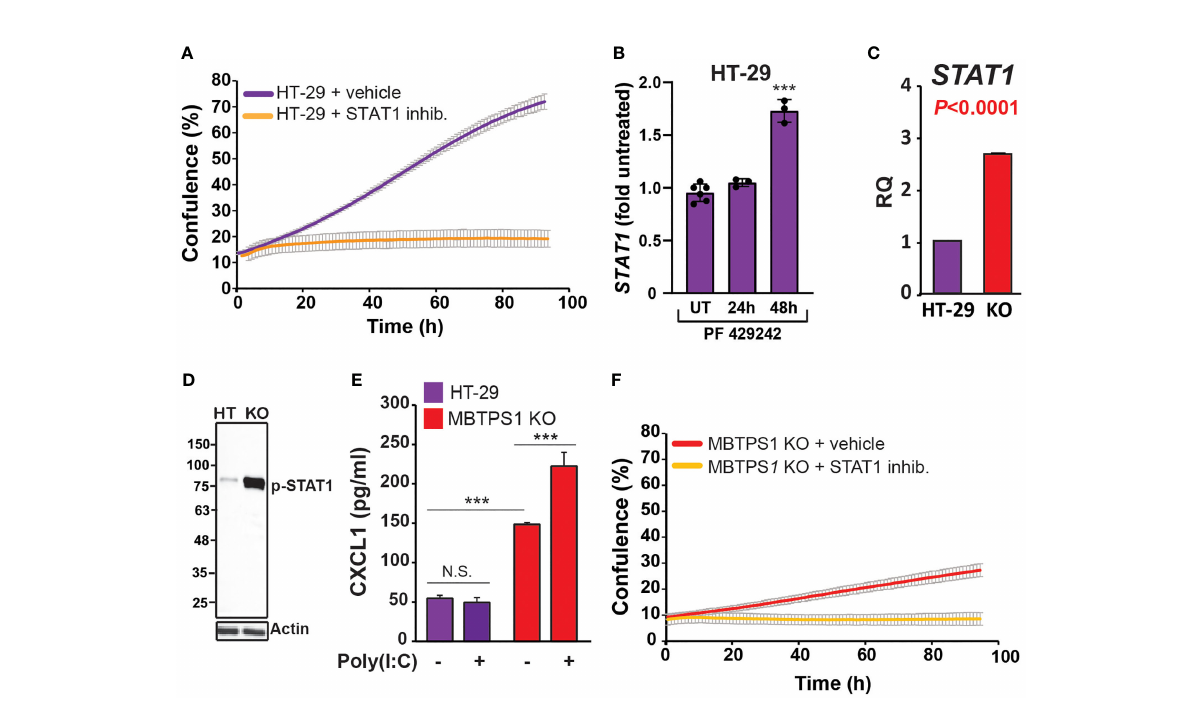
FIGURE 6 MBTPS1 knockout upregulates the type-1 interferon pathway. (A) STAT1 activity is critical for proliferation of HT-29 cells. Proliferation of HT-29 cells treated with either vehicle or 25 mM STAT1 inhibitor fl udarabine was tracked over 96 h using time-laps microscopy. Shown is an average ± SD n =3 for each condition. (B) Relative STAT1 mRNA levels 24 and 48 hours following treatment with 10 mM PF-429242 in HT-29 cells. n =3-6 One – Way ANOVA ***p<0.0001. (C) Relative mRNA levels of STAT1 in the original and MBTPS1 knockout HT-29 cells ( n =3, t-test, P<0.0001). The levels of STAT1 in the knockout are markedly elevated, in accordance with the transcriptome data. (D) Immunoblot of control HT-29 and MBTPS1 KO cells show elevated levels of phosphorylated STAT1 (p-STAT1). Representative blots of n=3. (E) MBTPS1 KO cells show a functional response to poly(I:C) stimulation. Shown is CXCL1 production in response to stimulation of HT-29 or MBTPS1 KO cells with 50 mg/ml poly(I:C) overnight ( n =4 repeats). (F) Proliferation of MBTPS1 KO cells treated with either vehicle or 25 mM STAT1 inhibitor fl udarabine. Shown is an average ± SD n=3 for each condition. N.S., not signi fi